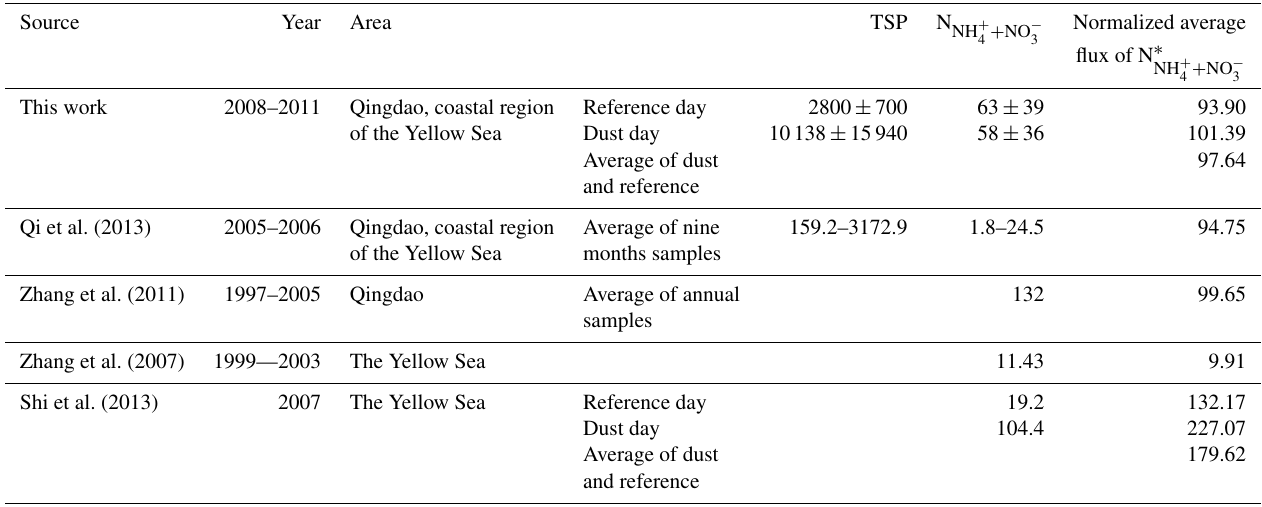
Table 9. Comparison of dry deposition flux and normalized flux of TSP (mgm − 2 month − 1 ) and N observations from other studies (mgNm − 2 month − 1